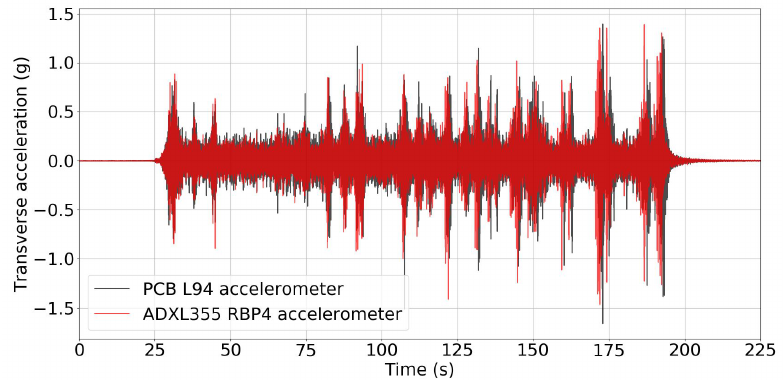
Figure 32. Transverse forced vibration record of a 48 km/h empty-load train on measurement channel